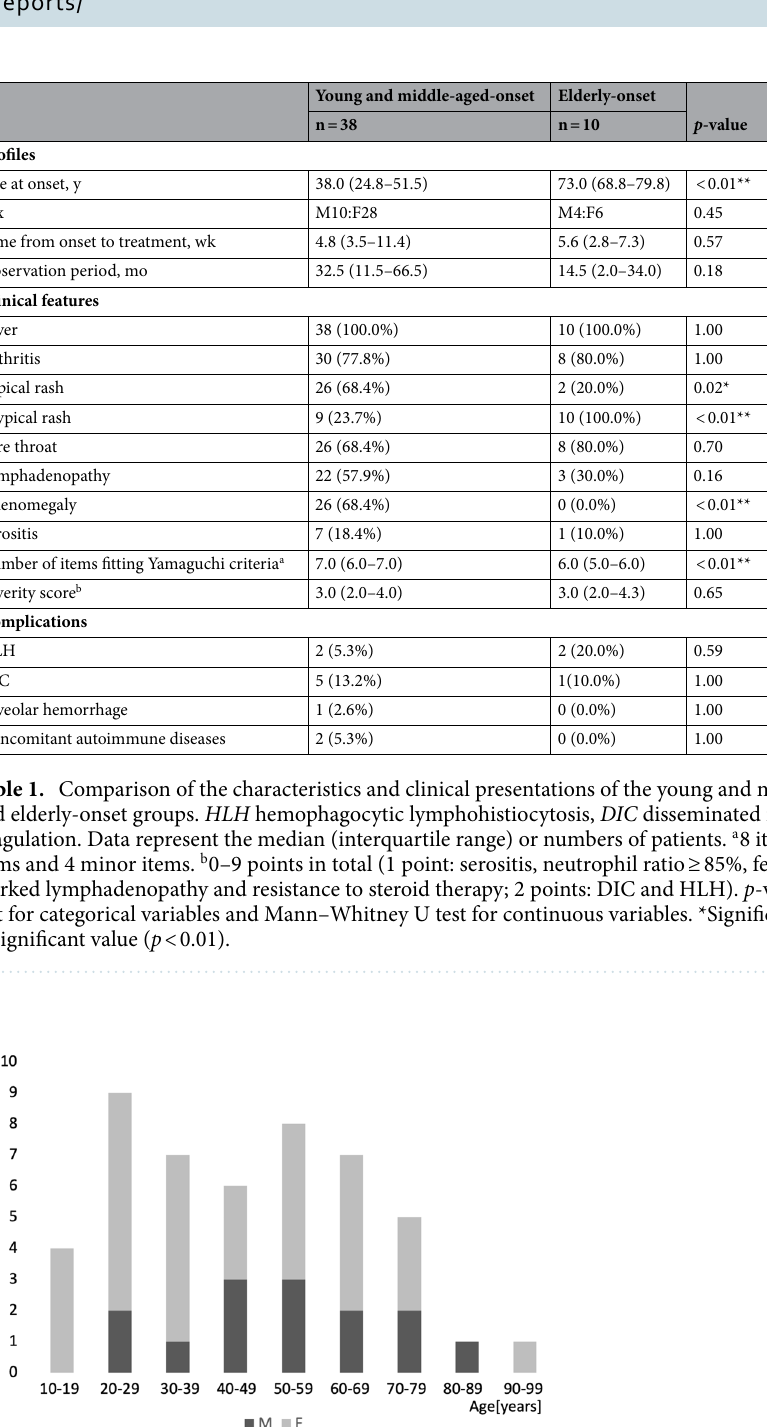
Figure 1. Distribution of age at onset and of sex. The distribution was bimodal, with peaks in the 20 s and 50